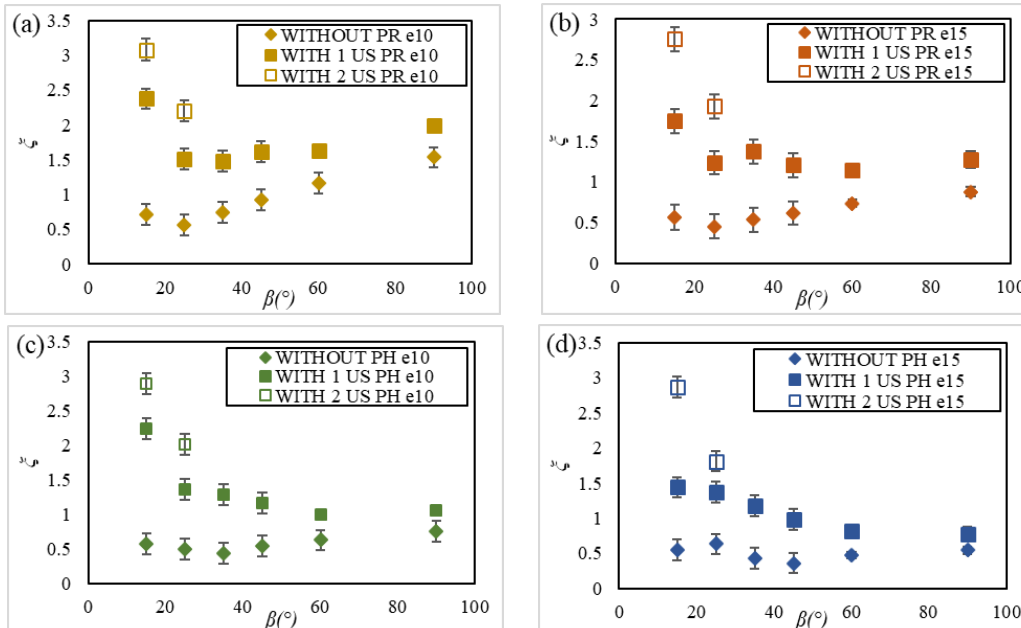
Figure 9. Comparison of measured head loss coefficients ξ without, with one or two U-shaped supports (US) for ( a ) PR for a bar spacing of 10, ( b ) PR for a bar spacing of 15, ( c ) PH for a bar spacing of 10, and ( d ) PH for a bar spacing of 15, as a function of the angle of inclination β .